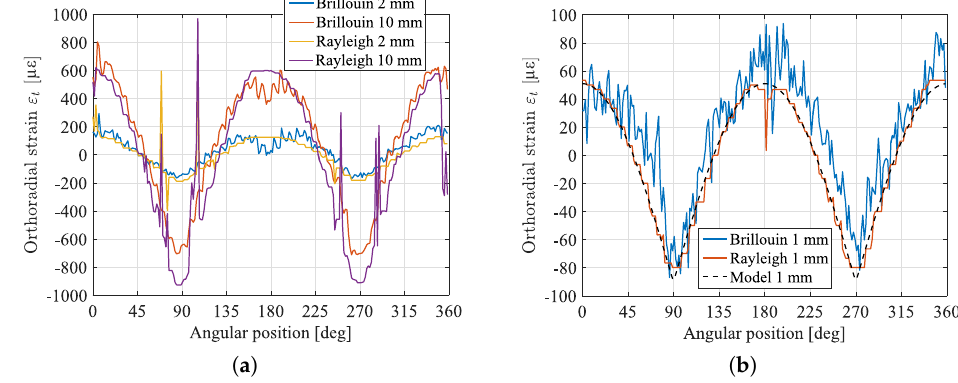
Figure 6. Comparison between Brillouin and Rayleigh scatterings. ( a ) Comparison for 2 mm and 10 mm of imposed displacement. ( b ) Comparison for low strain (1 mm) with the FE model simulation.